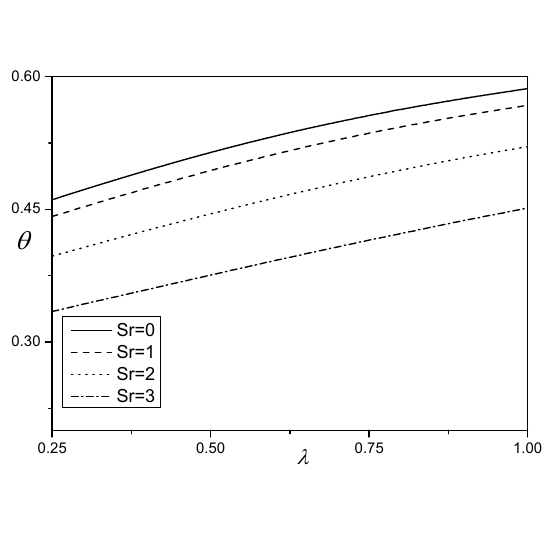
Fig. 9 Soret effect on f ( λ )